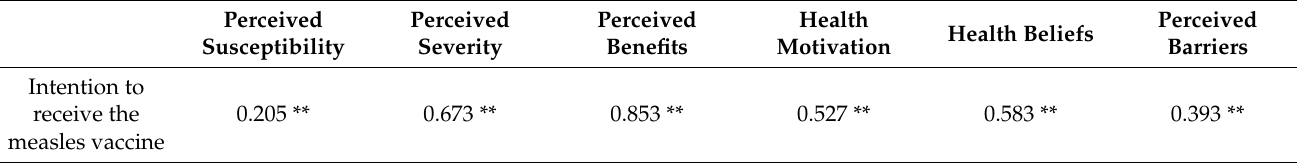
Table 2. Correlation between HBM categories and the intention to accept the measles vaccine.